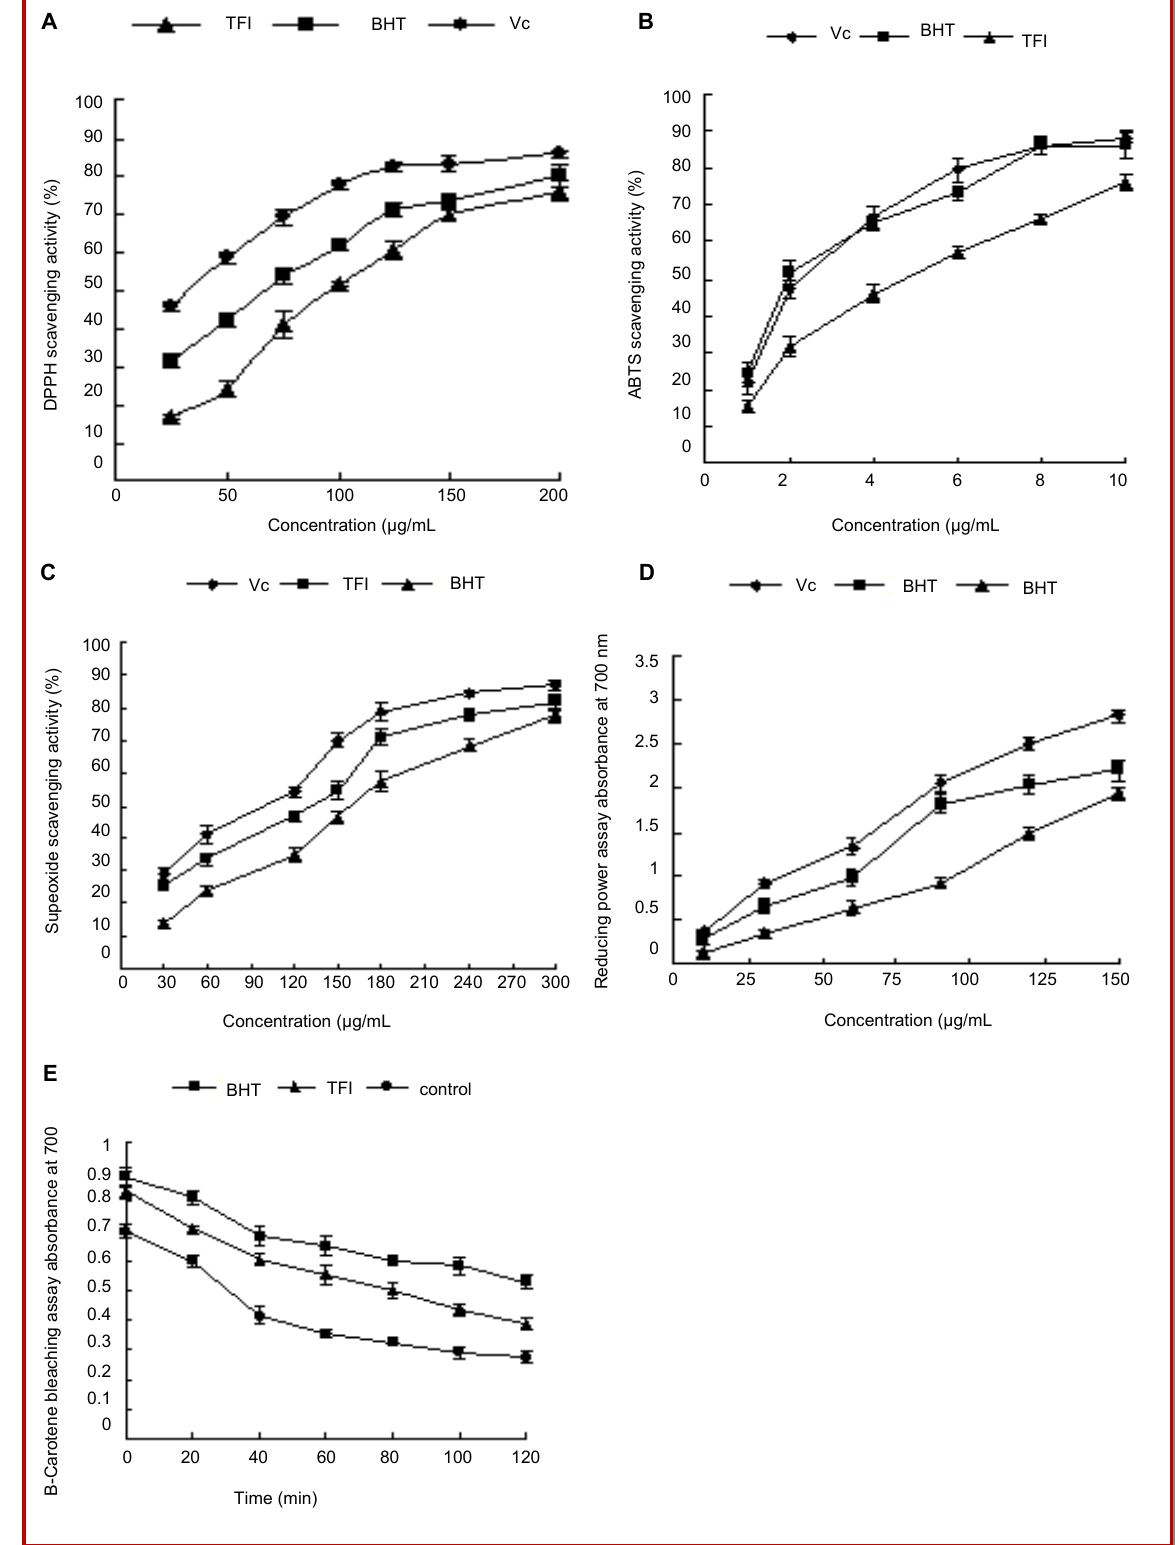
Figure 2: Anti-oxidant activities of total flavonoids of I. latifoliu as determined by the A) DPPH; B) ABTS; C) O 2 • － scavenging activity; D) Reducing power, and E) β - carotene bleaching